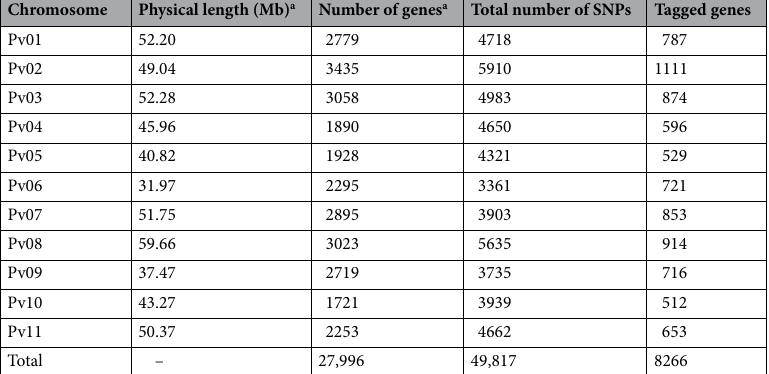
Table 1. Number of SNPs in each of the 11 common bean chromosomes in the set of 219 accessions from the Brazilian Diversity Panel. a Information obtained from the EnsemblPlants website (https ://plant s.ensem bl.org).